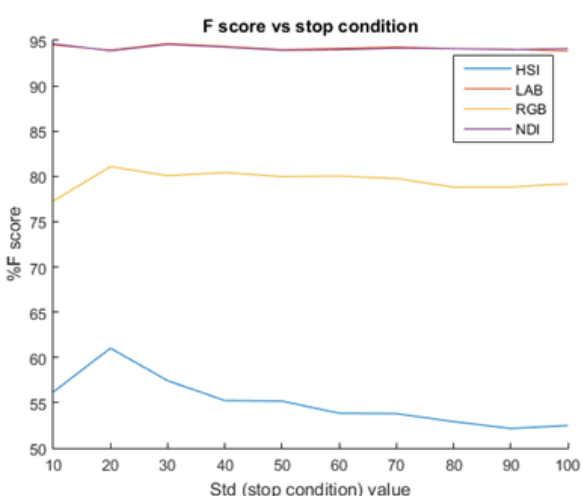
Figure 13. F-score vs. increasing STD value as the stop condition for the recursive function on the apple DB.